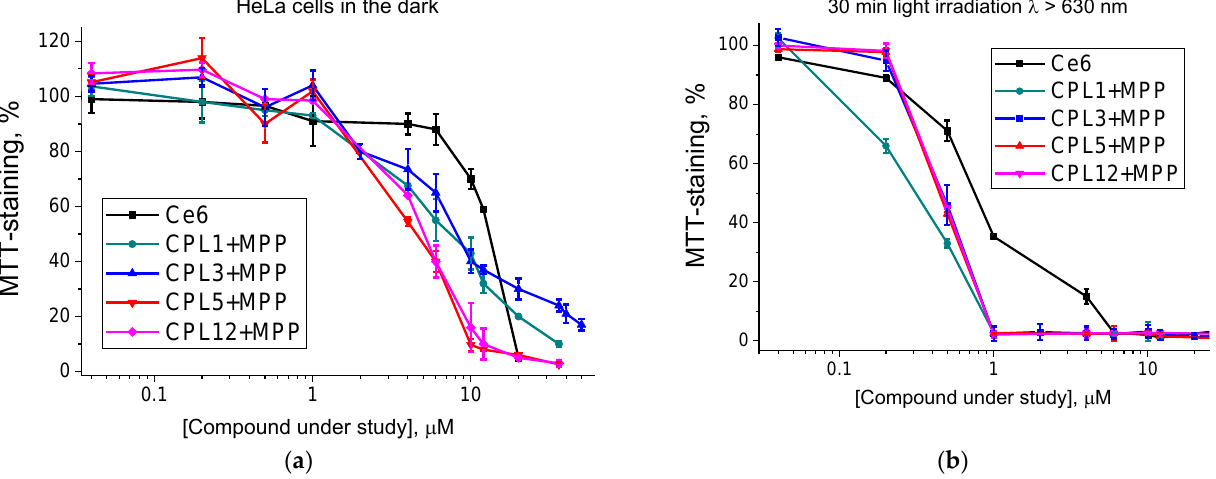
Figure 5. Phototoxicity of nanoparticles under study or reference PS (Ce6) in HeLa cancer cells: cells kept in the dark ( a ) and cells after 30 min light irradiation λ > 630 nm ( b ). All NPs under study have a pronounced phototoxic effect (Figure 5b), and the IC 50 dose of all NPs with MPP is 1.5–2 times higher than that for the reference dye Ce6 (IC 50 = 0.83 µ M, Table 2), which is one of the most effective PS currently used in clini- cal